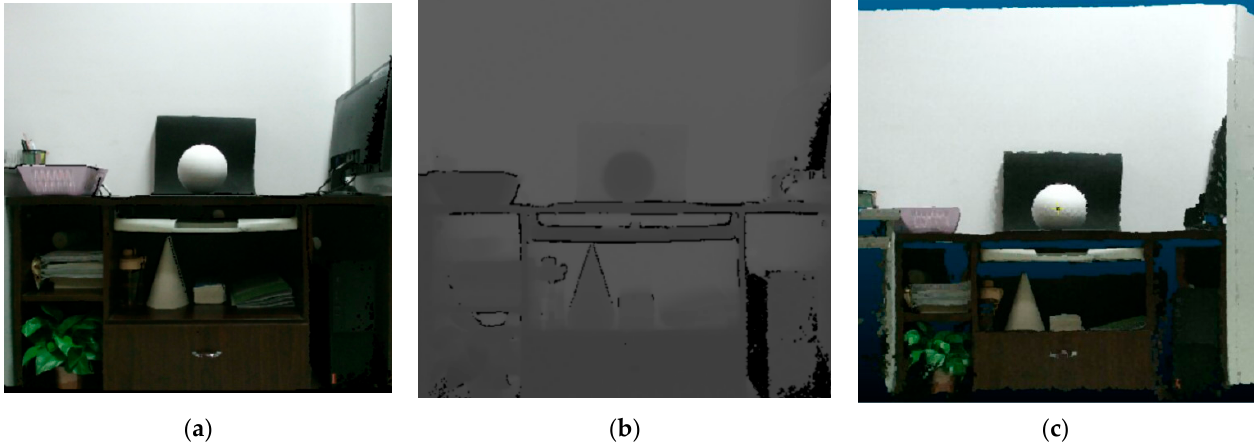
Figure 7. Images of a sphere taken by a Kinect V2. ( a ) Color image; ( b ) depth image; and ( c ) 3D point cloud data.